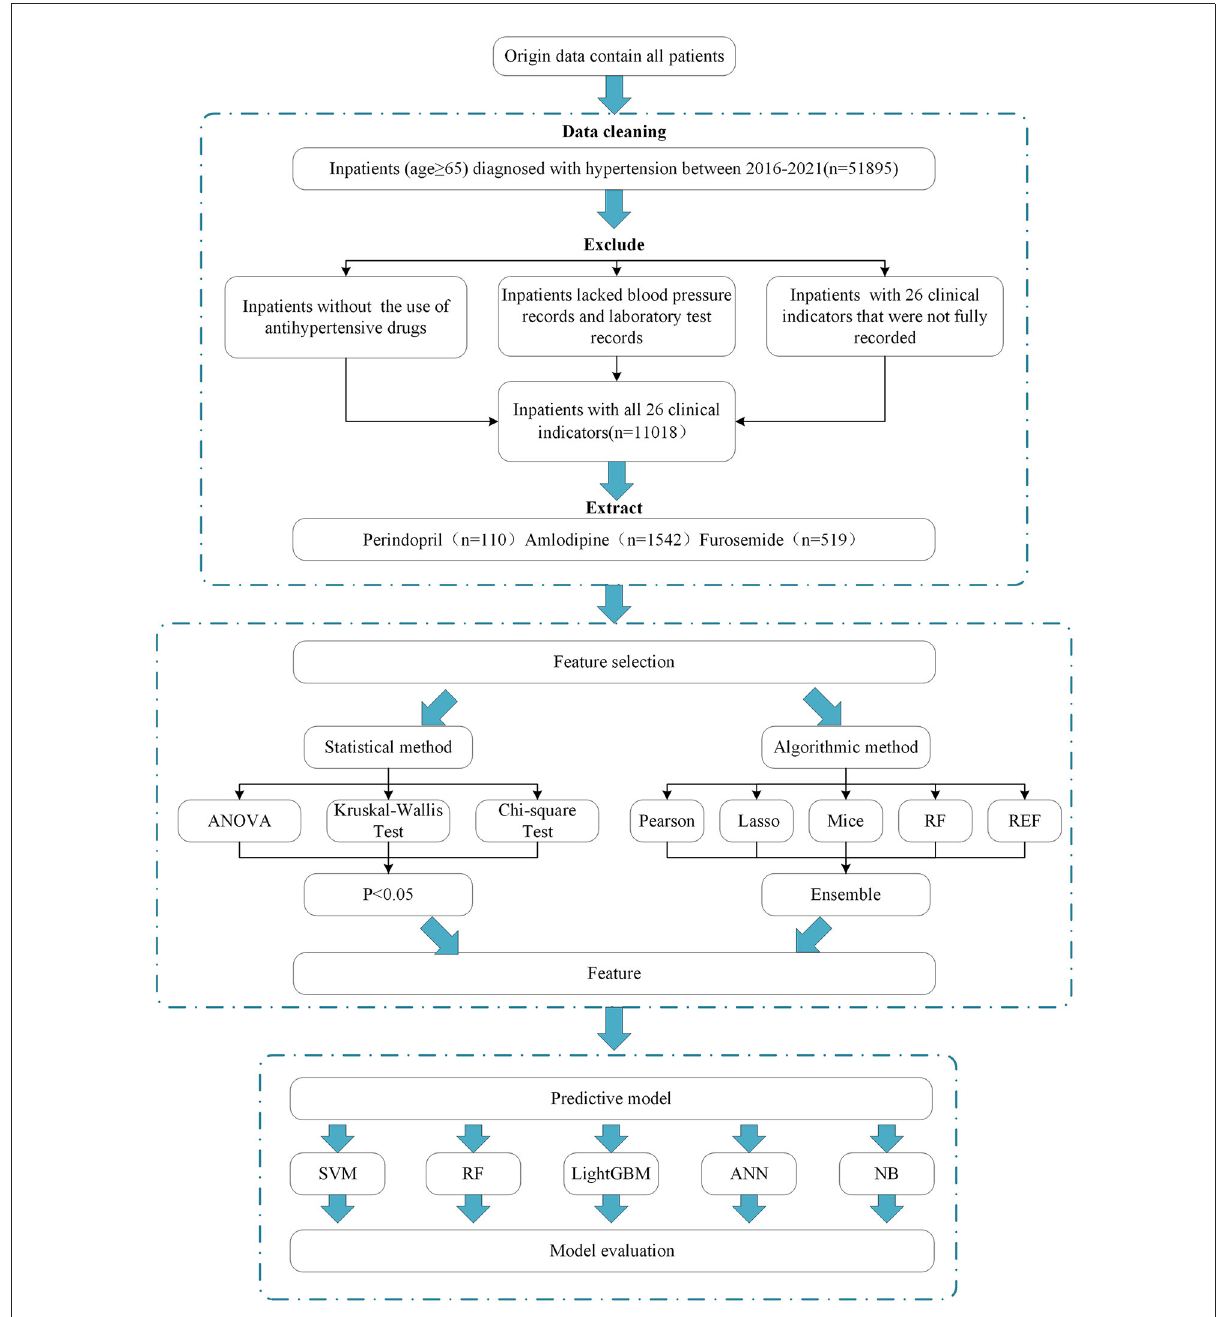
FIGURE1 The flow chart of the data process and analysis.